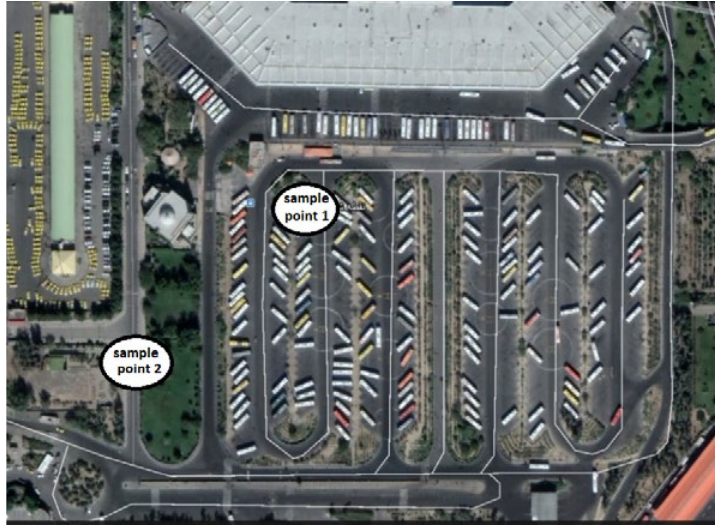
Fig. 2: Locations selected for soil sampling